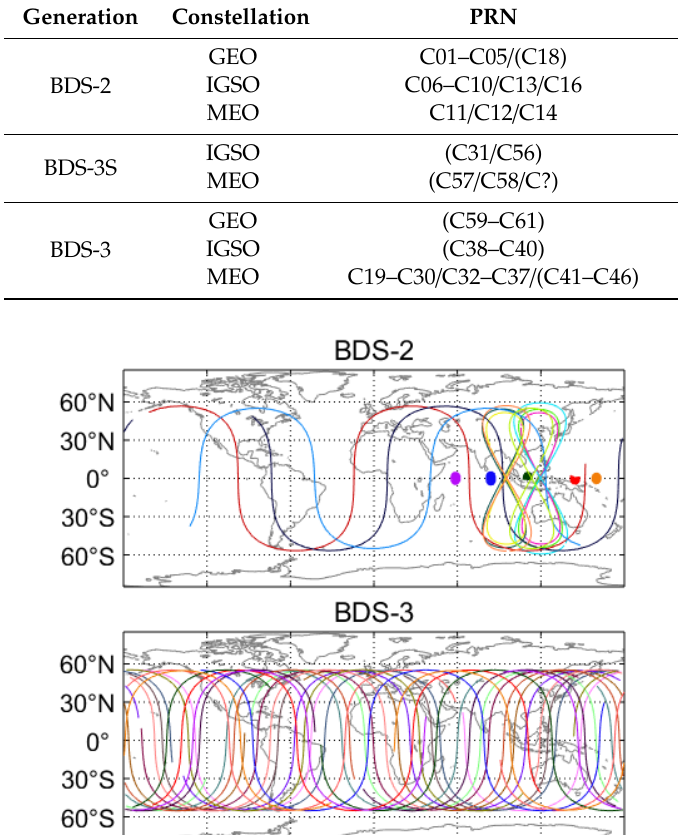
Table 1. Space segment of BeiDou navigation satellite system (BDS)-3 and BDS-2 as of September 2020.